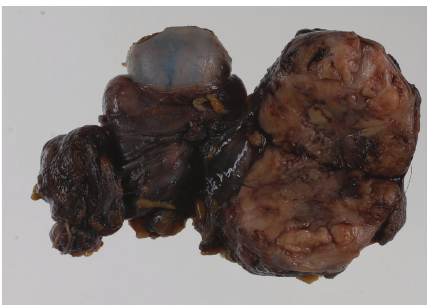
Figure 4: Leiomyosarcoma (right) is stained by antibody against calponin but dedifferentiated leiomyosarcoma (left) is not. × 20